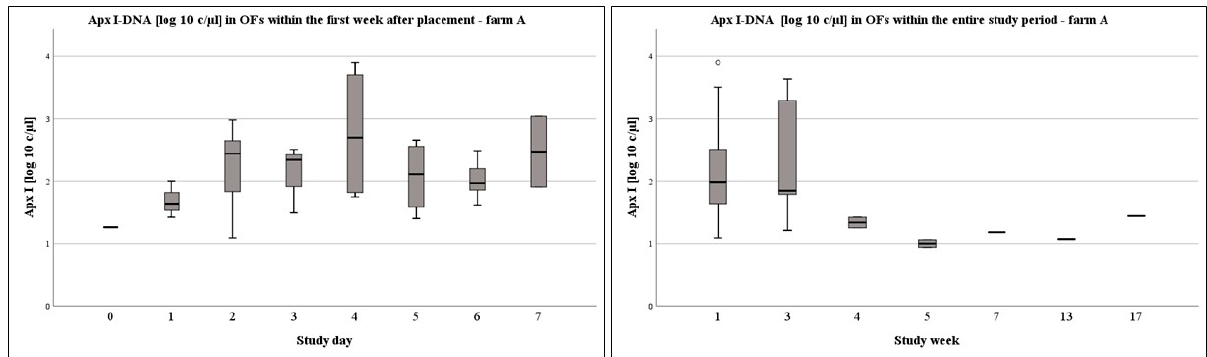
Figure 3. Boxplots of log10 c/µL Apx IV- and Apx III-toxin DNA in OFs over the entire study period at a weekly basis from farms A and B.